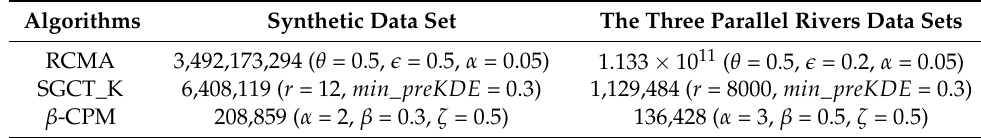
Table 2. The total time costs (microseconds) in algorithms with ideal parameters. Algorithms Synthetic Data Set The Three Parallel Rivers Data Sets